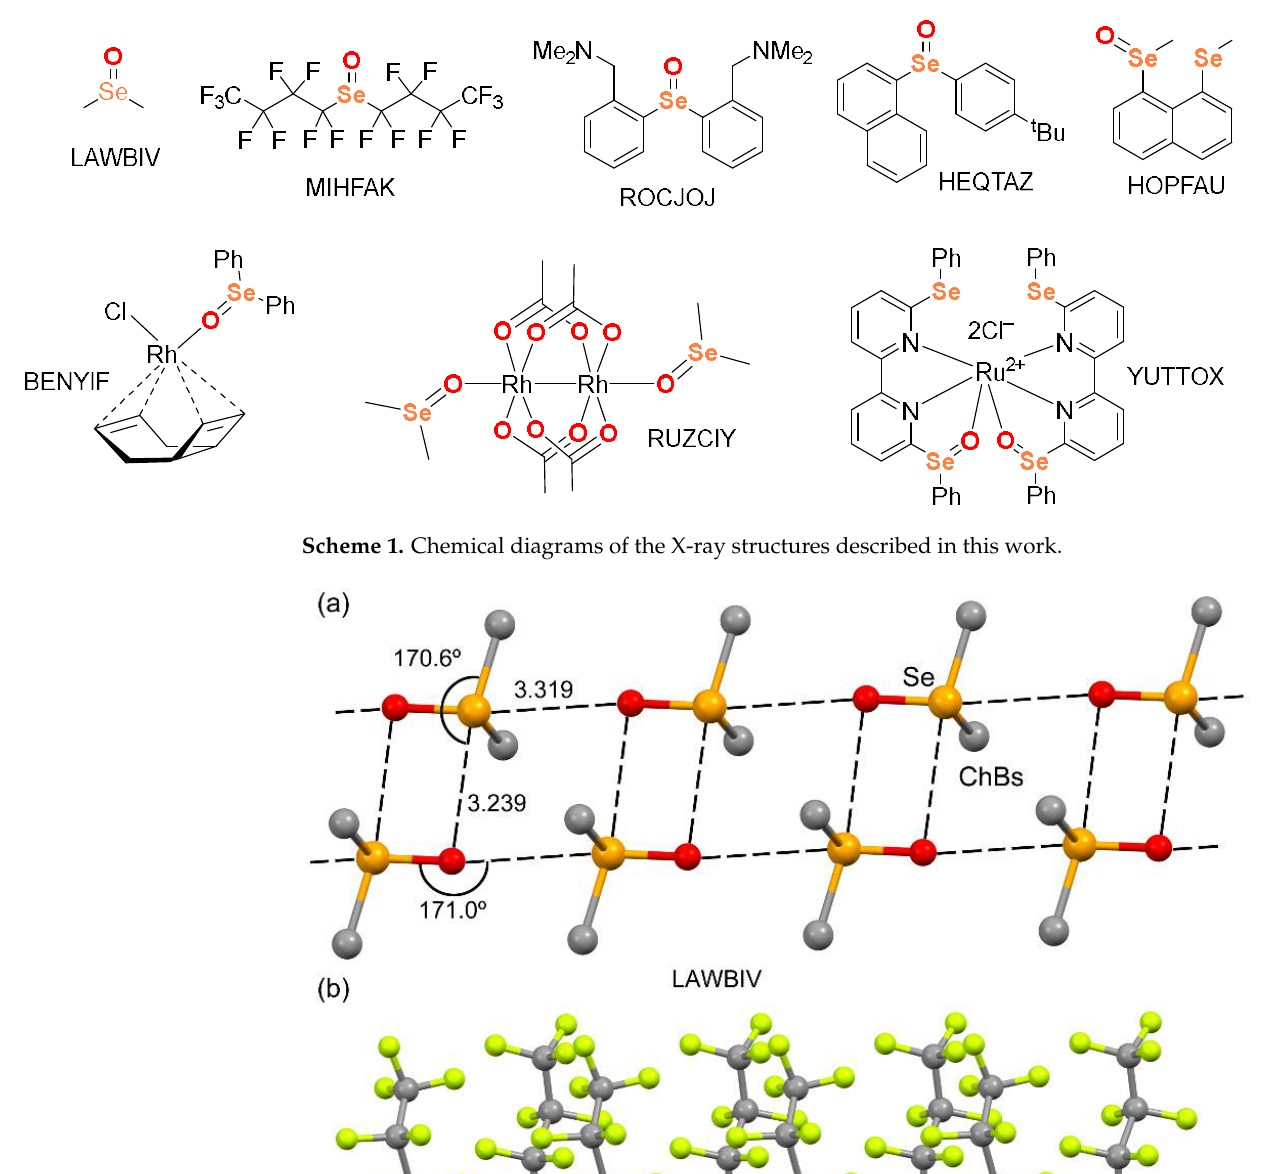
Figure 2. X-ray structures of LAWBIV ( a ) and MIHFAK ( b ). H atoms omitted and distances in Å.